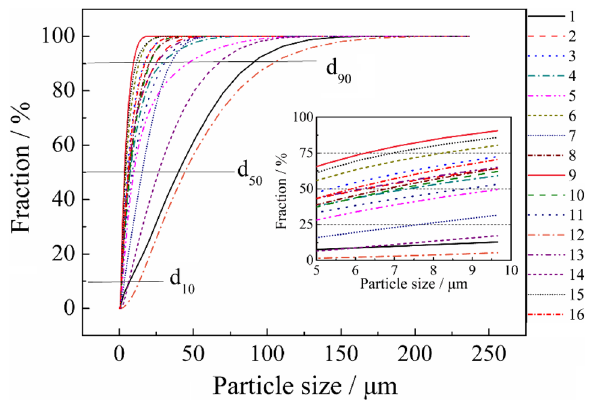
Table 3 Average mean value and range